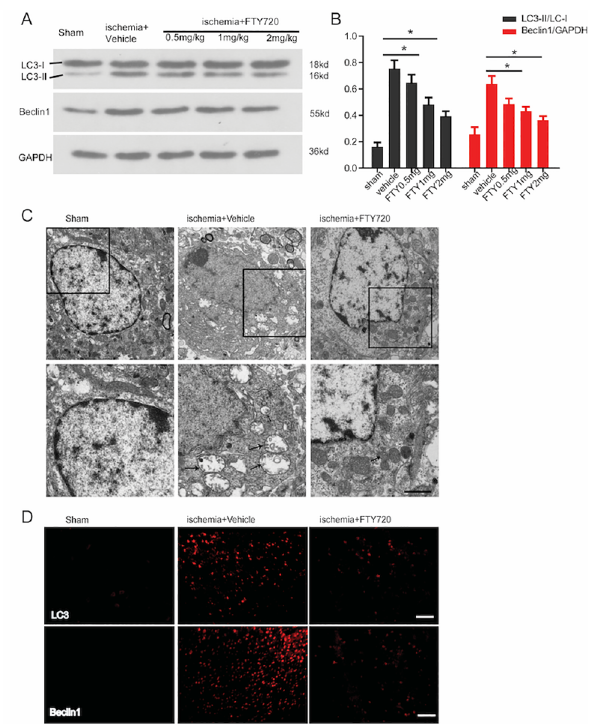
Fig 4. FTY720 attenuates activation of autophagy following ischemic stroke in a dose-dependent manner. A , The impact of increasingconcentrations of FTY720 on the expressionof Beclin1 and LC3 was evaluatedby western blotting. Results are representative of 4 independentexperiments. B, Quantificationof the results in panel A. (n = 4 for each group, * p < 0.05 vs. sham group, ** p < 0.01 vs. sham group, one-way ANOVA with Tukey post hoc test). C, Top, Representative electron microphotographs in neuronsin the sham, ischemia+vehicle, and ischemia+FTY720 treated groups at 3 days post photothrombicischemic stroke (A1-A3). Higher magnification images of the square area in A1-A3 showed abundantlysosomes and autophagosomes (arrows) in the ischemia+vehiclegroup, which was reversedby treatment with FTY720 (A4-A6). D. Representative images of LC3 and Beclin1 stainingin sham treated, ischemia+vehicle, and ischemia+FTY720